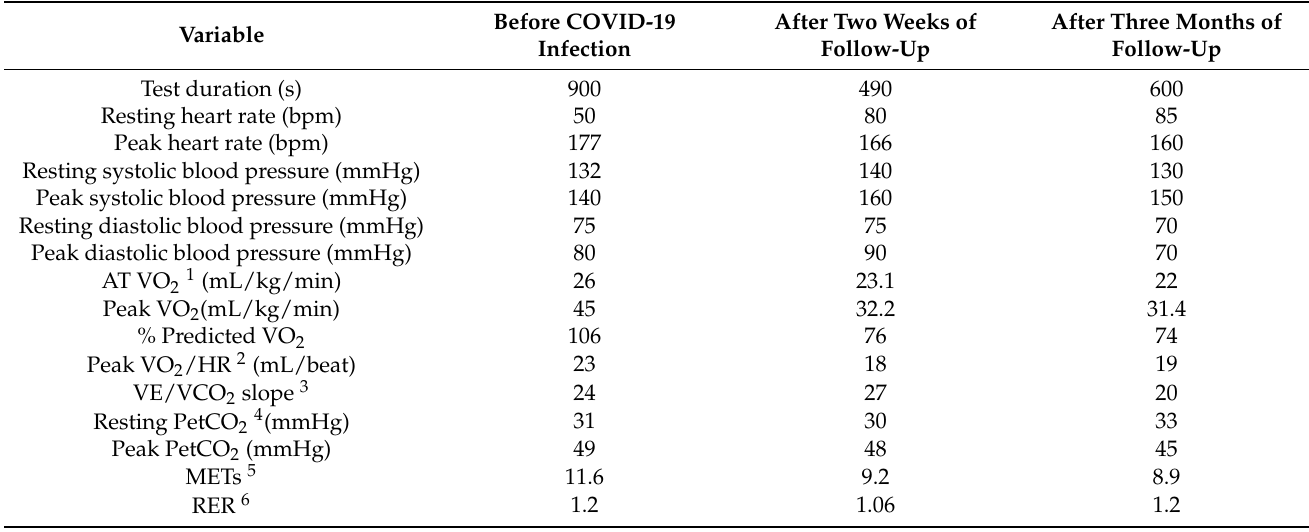
Figure 1. Resting ECG: sinus rhythm, heartrate = 95/min, AxQRS + 70, narrow QRS complex, R/S in leads D2, D3, aVF, r/S in leads V2, V3 with unifocal premature ventricular contraction with left bundle branch block morphology. Table 2. Parameters of cardiopulmonary exercise testing before COVID-19 infection in the athlete and after two weeks and three months of